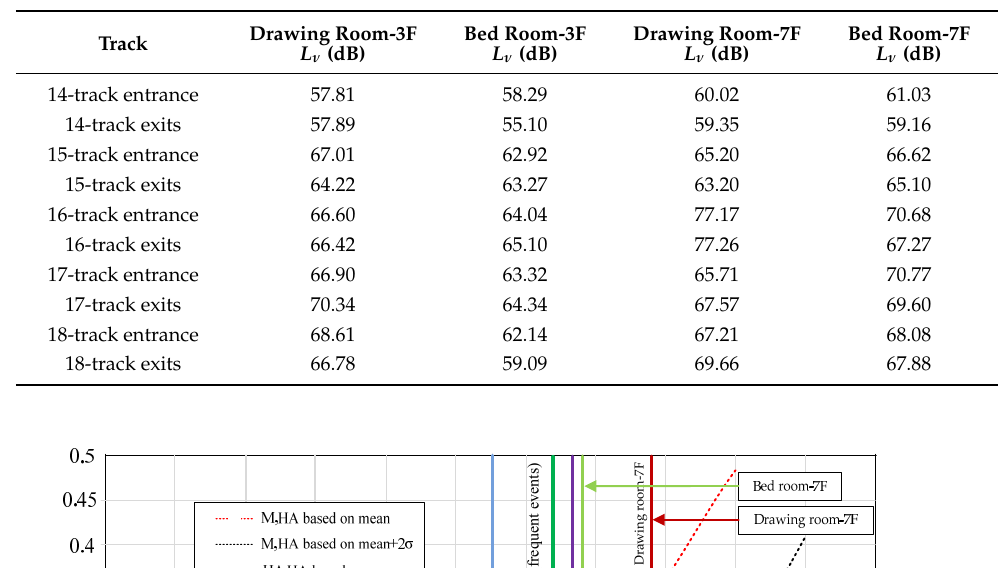
Table 4. Evaluation of vibration levels at the measurement point according to the US vibration standards.